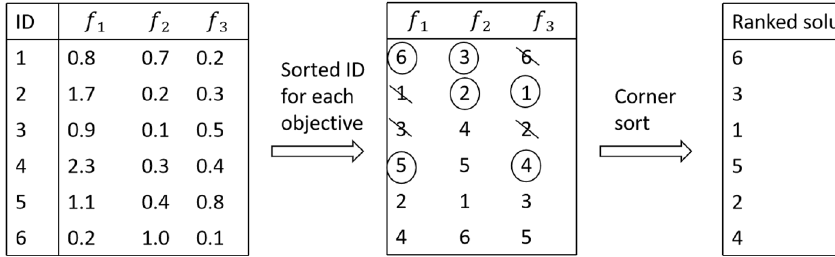
Fig. 3 Corner sort procedure implemented in this study